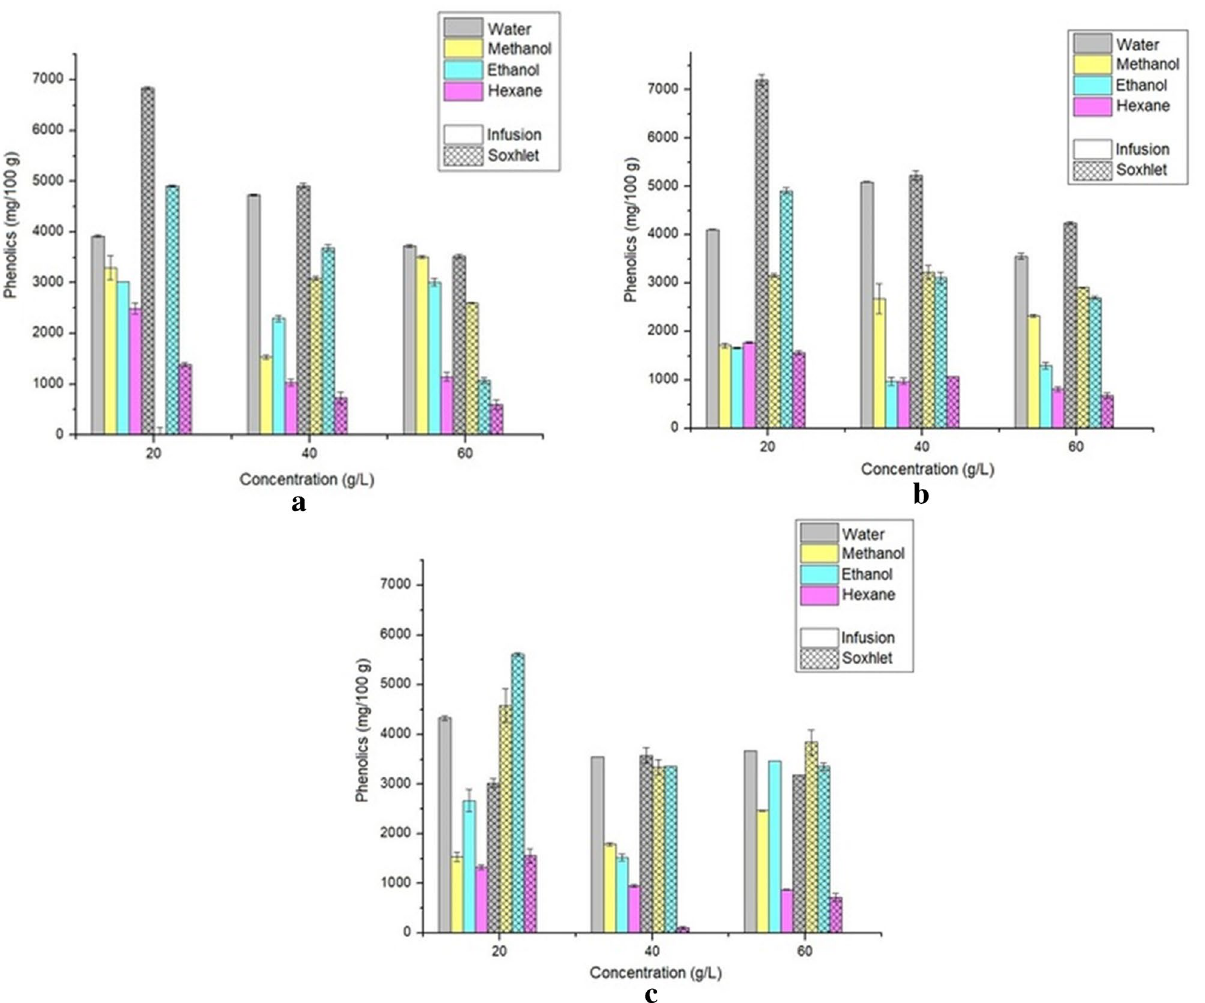
Figure 5. Concentration of total phenols using 2 h ( a ), 4 h ( b ), and 6 h ( c ) as extraction